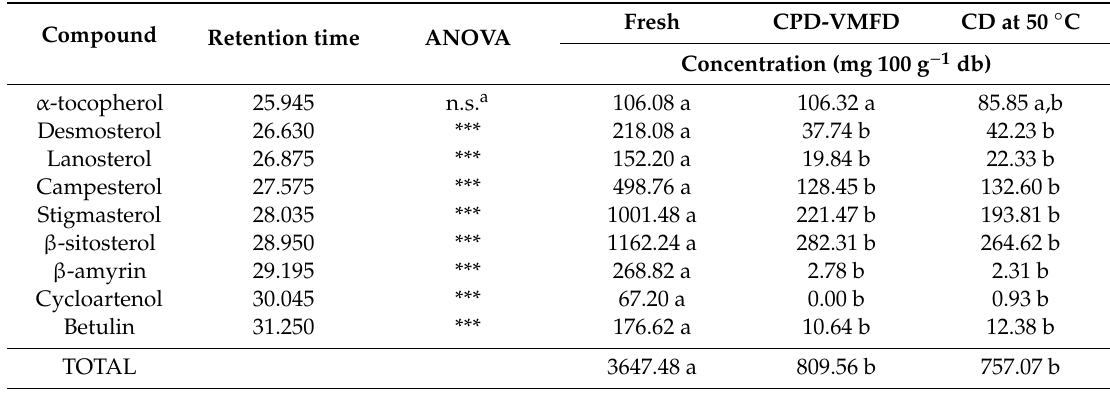
Table 5. Concentration of phytosterols influenced by drying